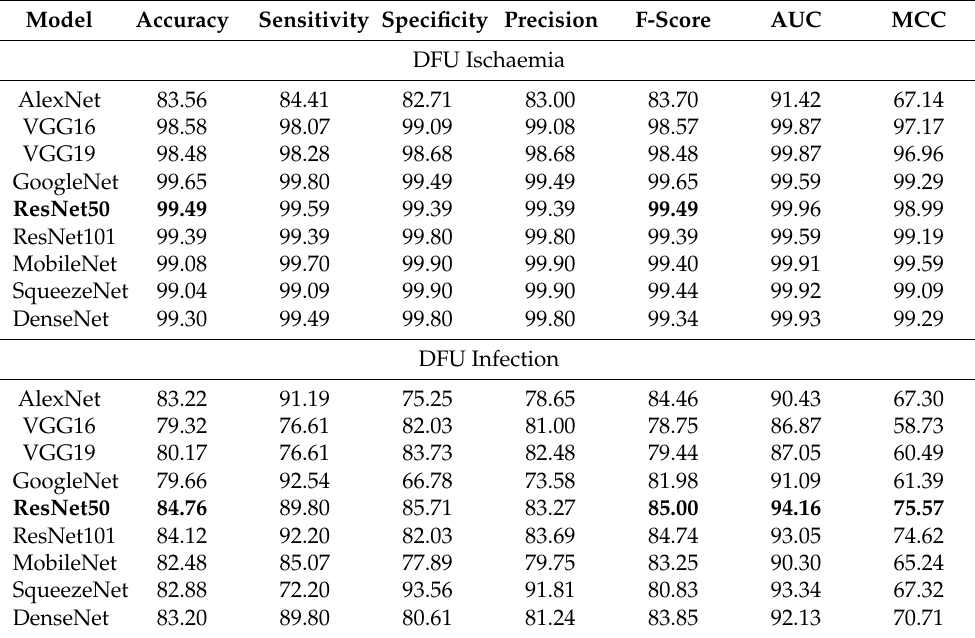
Table 1. Performance comparison of pre-trained AlexNet, VGG16/19, GoogleNet, ResNet 50/101, MobileNet, SqueezeNet, and DenseNet on test set of DFU2020 Part-B